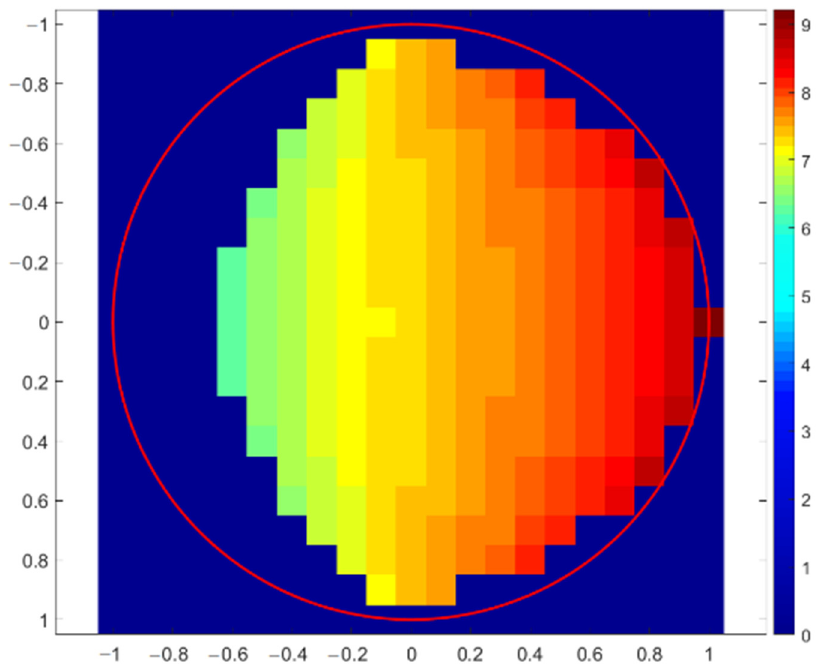
Figure 6. Copper concentration map of sterling silver sphere determined with Monte Carlo simulation of XRF scanning (in XY-axes) applying Cu-K α and Ag-L lines. The correct Cu concentration was 7.5%.